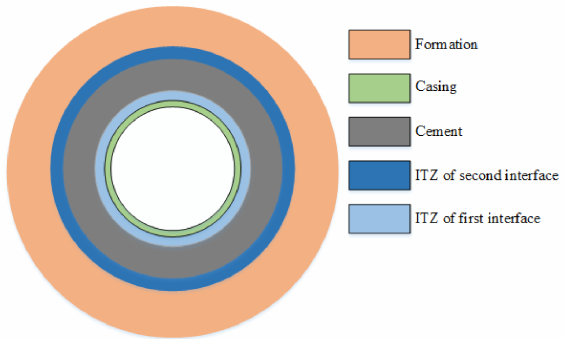
Figure 1. Schematic diagram of the transition zones in cement